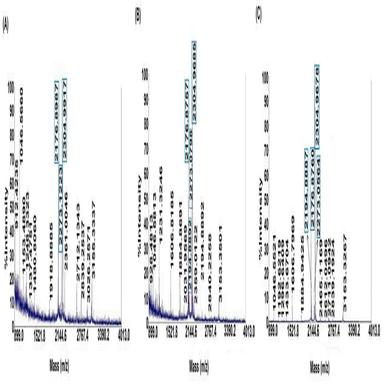
Detection and molecular localization of AGEs in Mb modified with MG for 28, 35 and 42 days. Tryptic mass spectra of Mb modified with MG for 28 days (A), 35 days (B) and 42 days (C), respectively. The MG-modified peaks are marked in each spectrum.